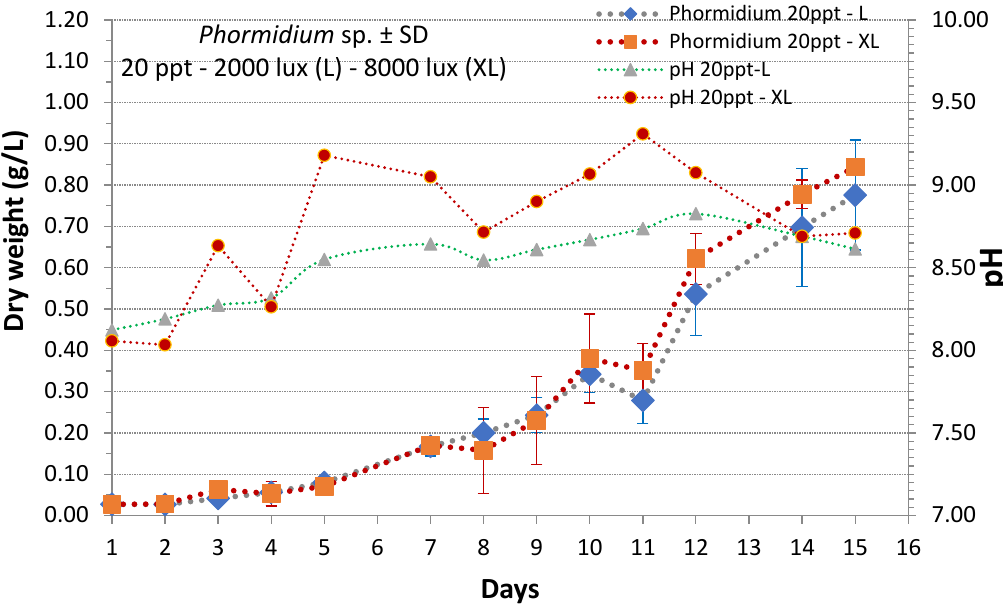
Figure 5. Growth curve and pH values for the period of a culture of Phormidium sp. at a salinity of 20 ppt in two light regimes: “ high light ” - “ XL ” -8000 lux and “ low light ” - “ L ” -2000 lux.